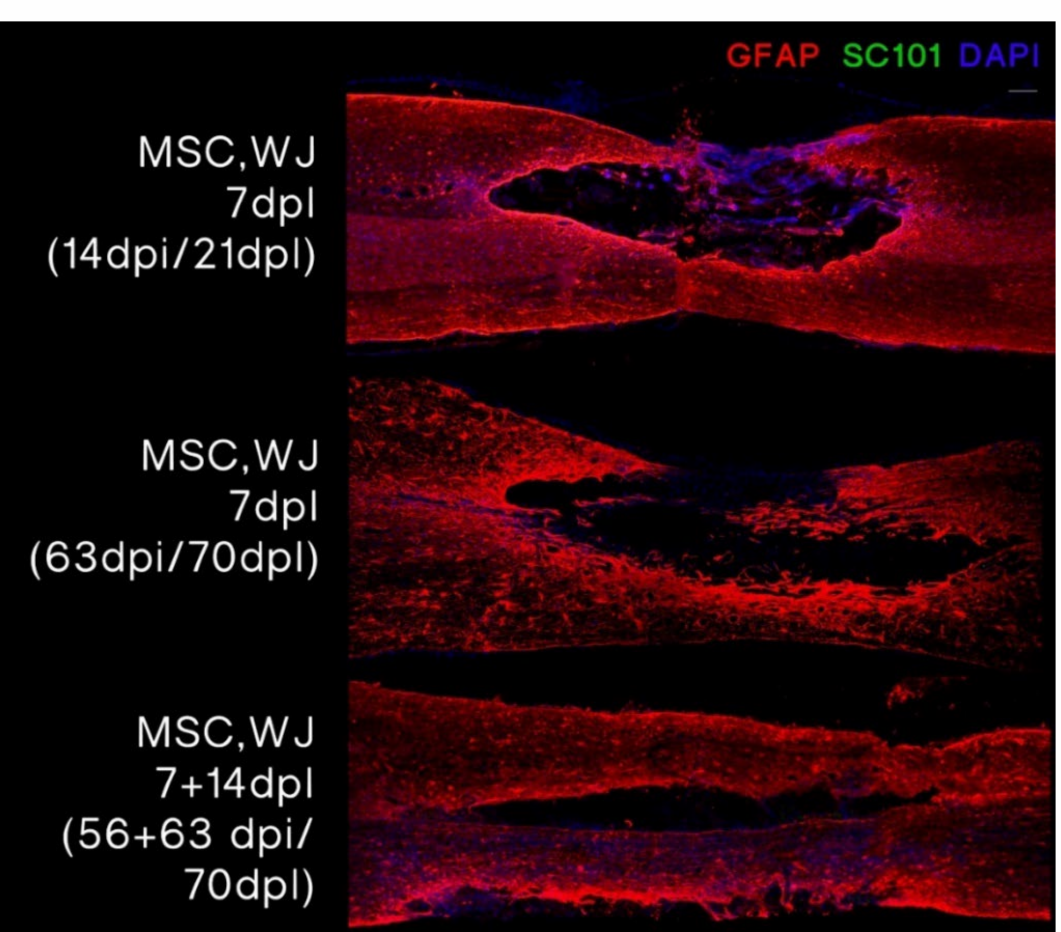
Figure 6. MSC,WJ localization after intrathecal administration at 21 or 70 days post-lesion (dpl), 14 days post-injection (dpi) or 63/56 + 63 dpi). Representative images of each group with transplanted MSC,WJ. No staining for SC101 was observed around or inside the lesion. GFAP staining in red, SC101 in green and DAPI in blue. Bar scale: 100 µ m. n =